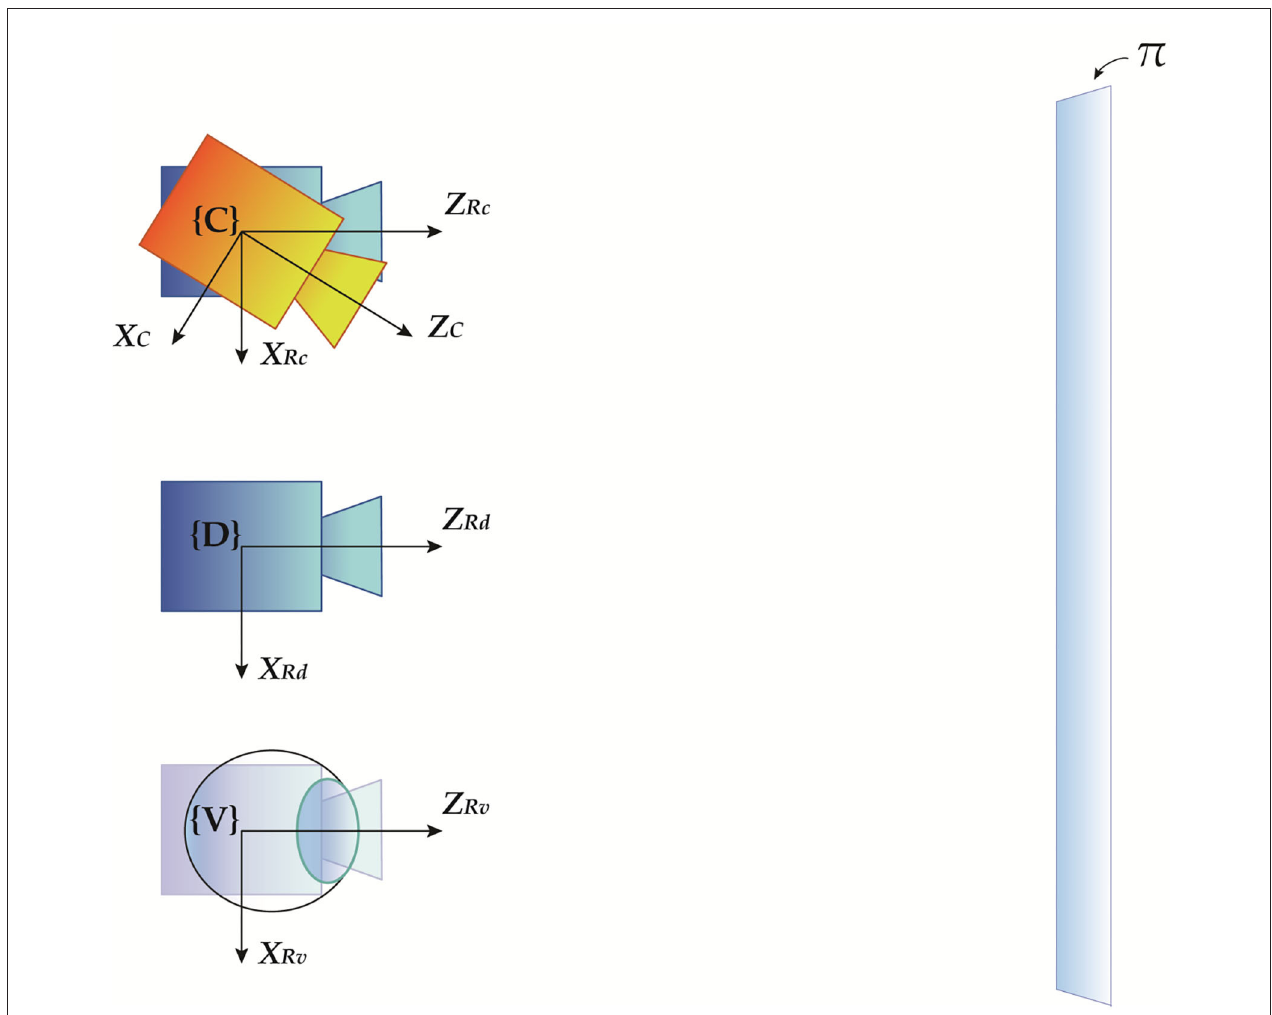
FIGURE 2 | Geometrical representation of the spatial relationships between the four reference systems involved in the camera-based calibration procedure, illustrating the relevant coordinate systems: the ideal on-axis virtual rendering camera R D , the real off-axis rendering camera associated with a generic calibration position R C , the physical viewpoint camera used as a replacement of the user’s eye C , and the off-axis rendering camera associated with the real user’s eye position. Rendering cameras are black-colored, whereas the physical viewpoint camera is